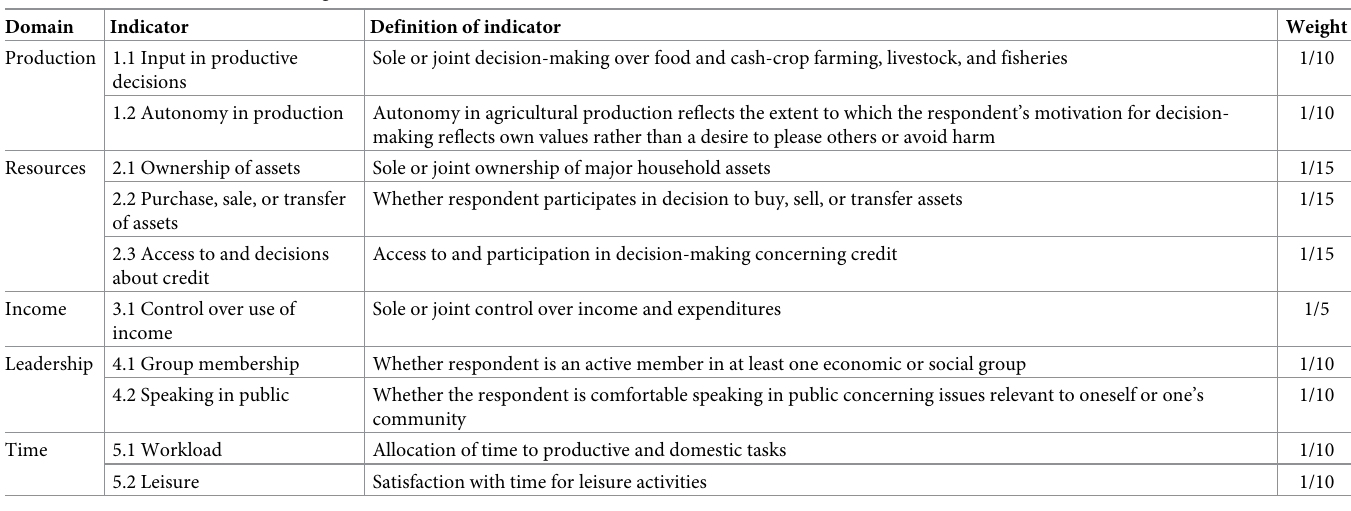
Table 1. Domains, indicators, and weights in the